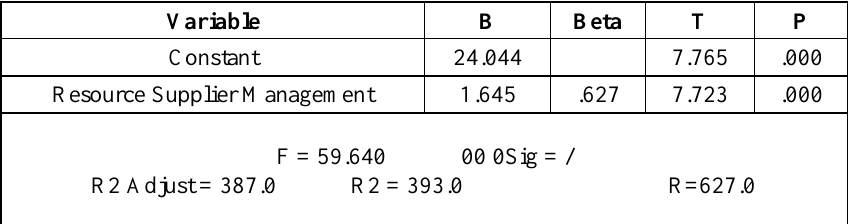
Table 3. Results of regression analysis for the second